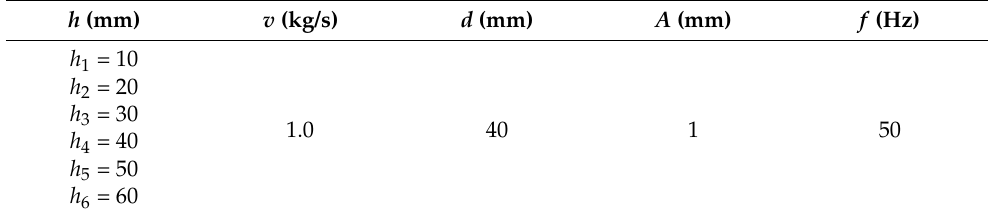
Table 5. Simulation parameters at different filling heights.